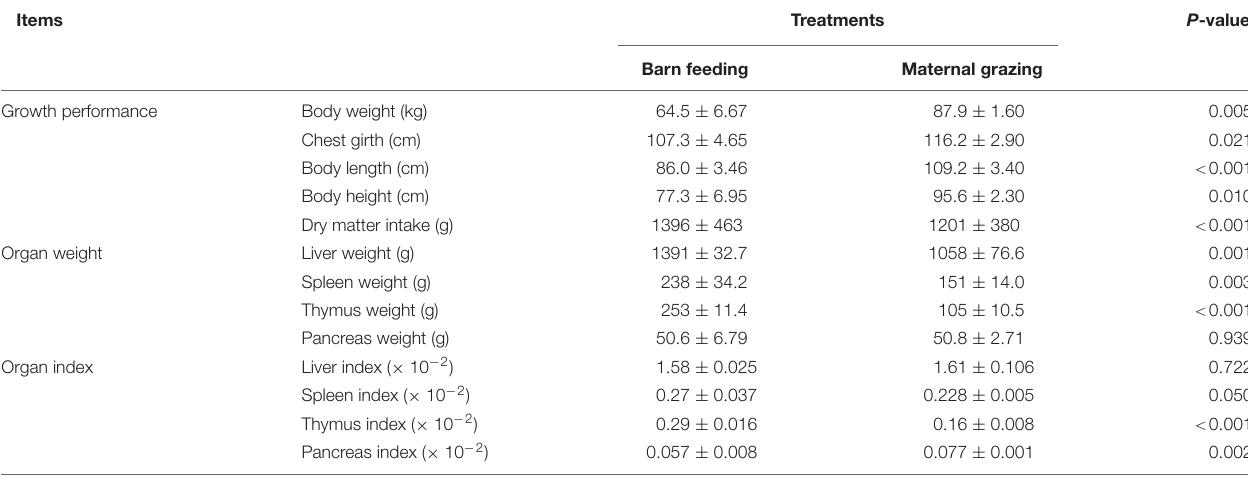
TABLE 1 | Effects of two feeding strategies (maternal grazing and barn feeding) during early life on the dry matter intake, body weight and body size traits, organ weight, and organ index of yak calves. Items